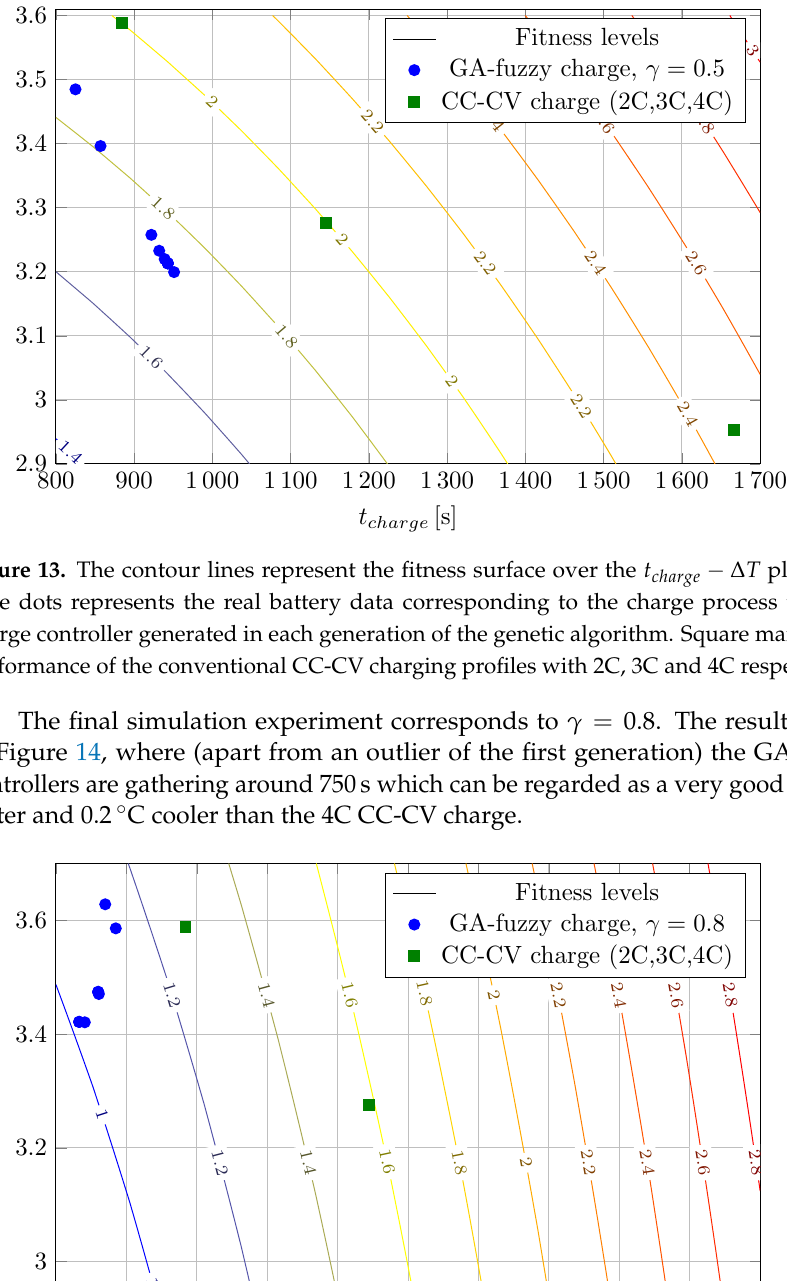
Figure 14. The contour lines represent the fitness surface over the t charge Blue dots represents the real battery data corresponding to the charge process using the fuzzy charge controller generated in each generation of the genetic algorithm. Square markers denote the performance of the conventional CC-CV charging profiles with 2C, 3C and 4C